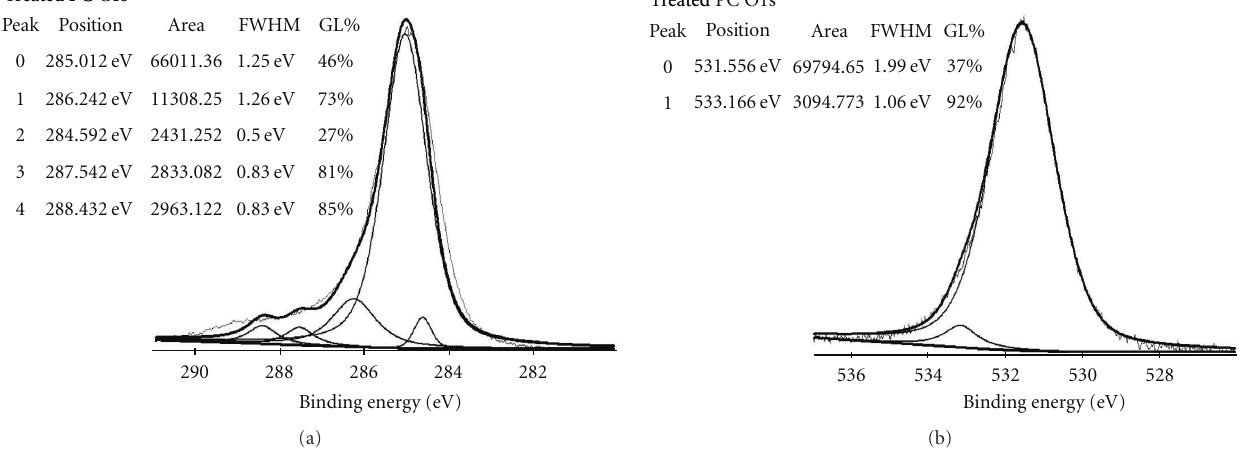
Figure 10: XPS spectra of (a) C1s peak (b) O1s peak of plasma-treated PC